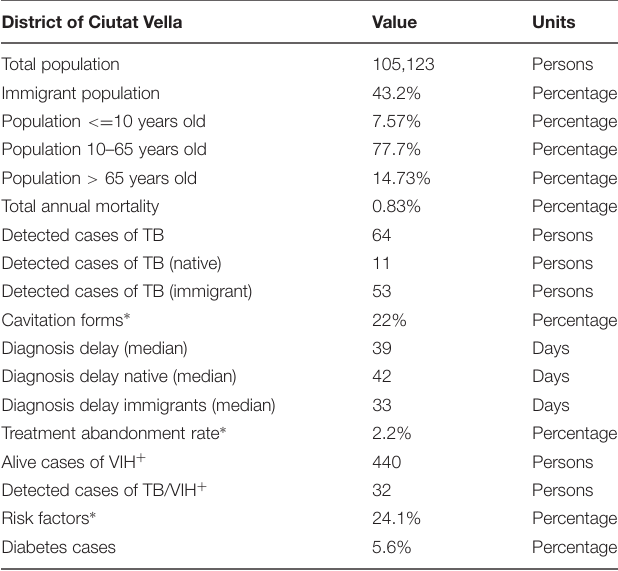
TABLE 1 | Official data of Ciutat Vella used in simulations (Ajuntament de Barcelona, 2012; García de Olalla et al., 2012; Bartoll et al., 2013; Orcau i Palau et al., 2013; Bartoll,